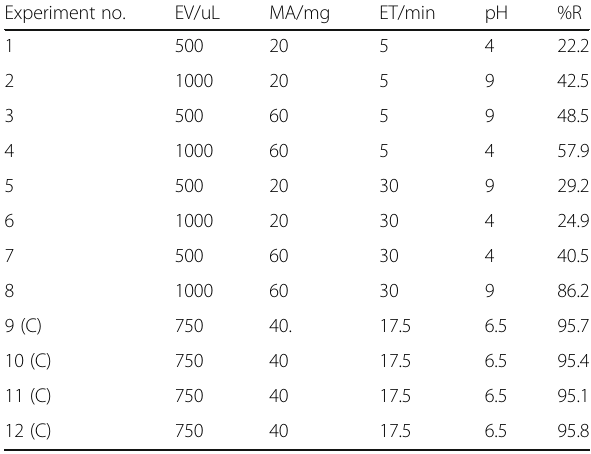
Table 2 Optimization parameters and their corresponding values for dispersive solid-phase microextraction of CBZ. C central point or middle value Experiment